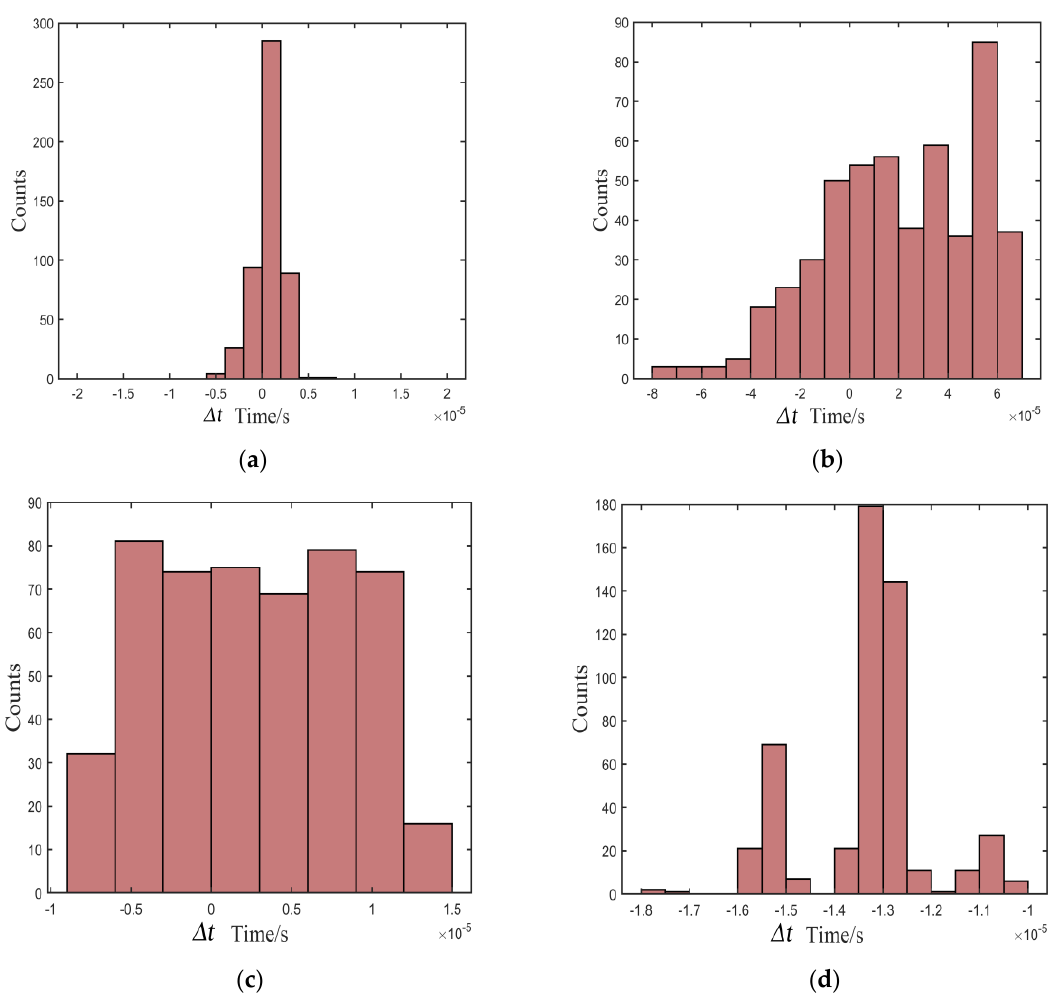
Figure 7. Distribution of deviation in the environment of 10 dB: ( a ) proposed, ( b ) Kurz, ( c ) TKEO, and ( d ) high-order statistics methods.